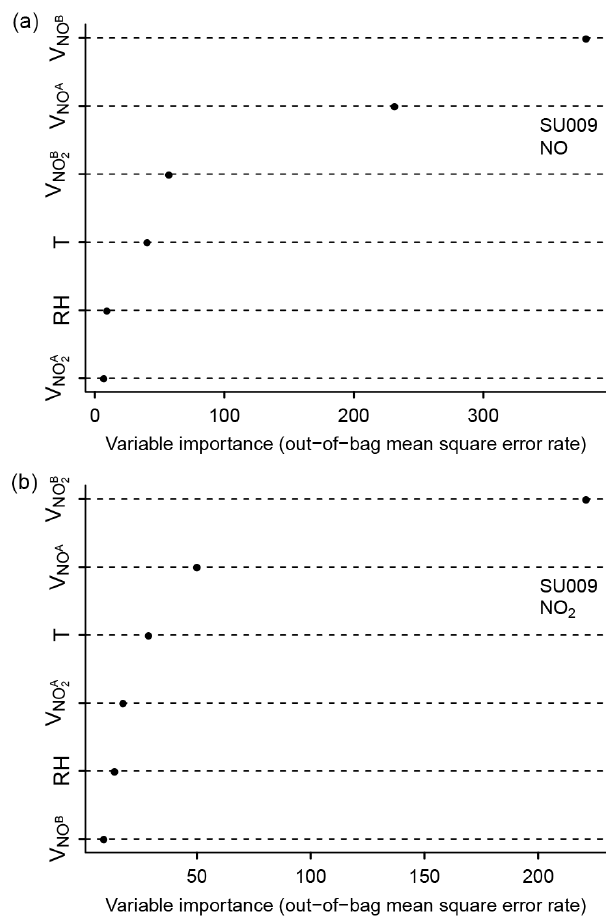
Figure 3. Variable importance plot for the prediction by SU009 of NO (a) and NO 2 (b)